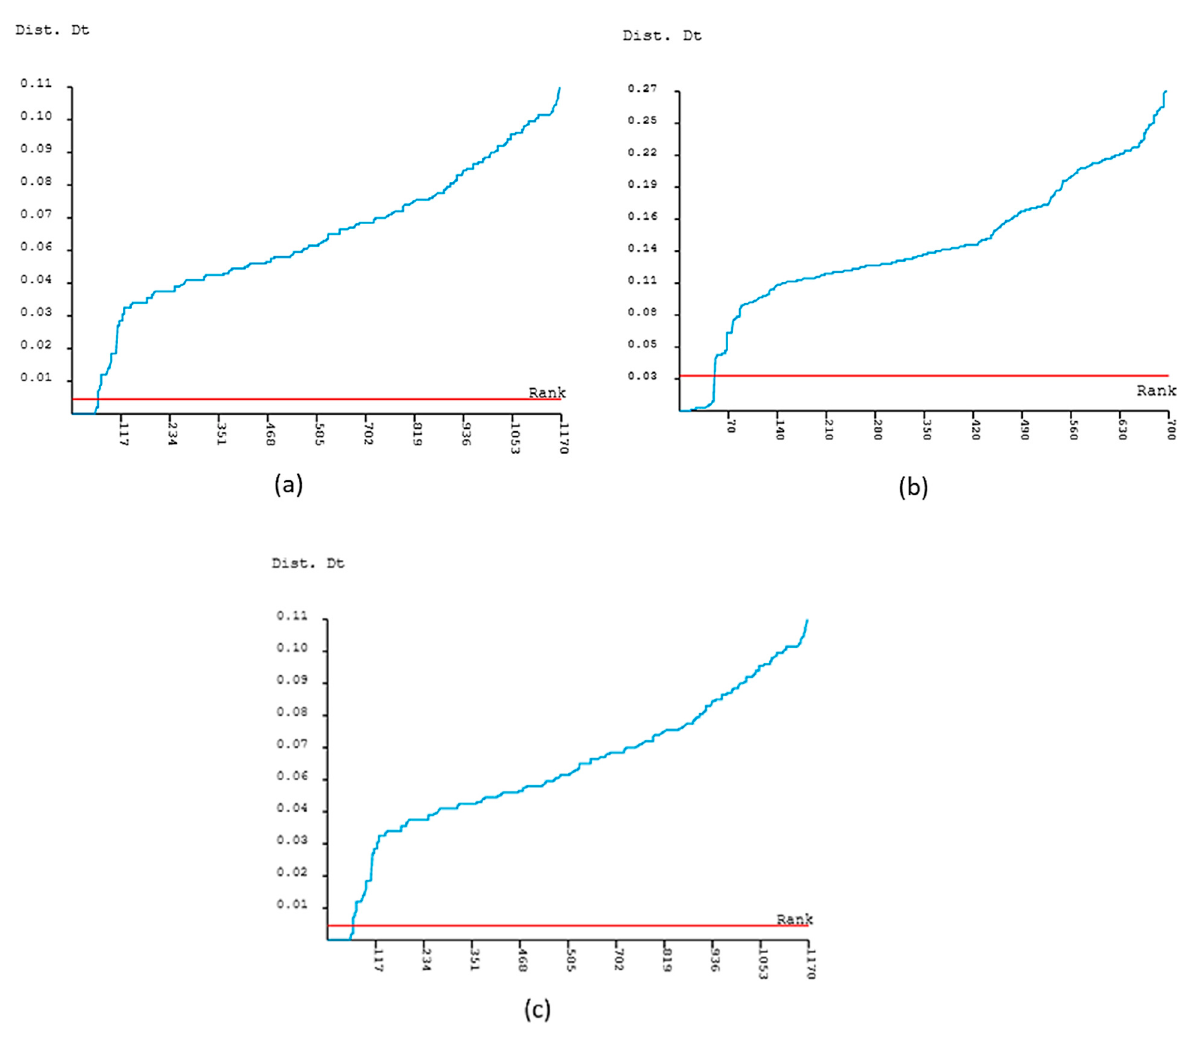
Figure 4. Threshold distance ranking the best partition for species delimitation. ( a ) matK 2nd partition (ASAP score = 2.50, Nb = 13, p = 0.0027); ( b ) ITS2 2nd partition (ASAP score= 2.50, Nb = 11, p = 0.042); ( c ) rbcL 2nd partition (ASAP score = 4.50, number of species (Nb) = 18, p = 0.0052). Overall, in the rbcL dataset, the ASAP and SVM methods successfully differentiated Paronychia arabica from Scelerocephalus arabicus , and resolved the Suaeda genus ( Suaeda ae- gyptiaca from Suaeda vermiculata , whereas Haloxylon persicum and Haloxylon salicornicum could not be discriminated using all three methods (ABGD, ASAP, and SVM) (Figure 3a). Moreover, in the rbcL dataset, ASAP alone was able to differentiate the Amaranthus genus ( Amaranthus viridis and Amaranthus hybridus ), while SVM alone was able to delimit the Calligonum genus ( Calligonum crinitum and Calligonum comosum ) (Figure 3a). In the matK dataset, Suaeda aegyptiaca and Suaeda vermiculata were only resolved by SVM (Figure 3b), while in the ITS2 dataset, both the species seemed to be accurately dif- ferentiated using all three methods (ABGD, ASAP, and SVM) (Figure 3c). Altogether, 17 species were successfully resolved from the 20 barcoded species using the rbcL, matK, and ITS2 markers, though the matK and ITS2 datasets lacked enough species member- ships for all 20 species.